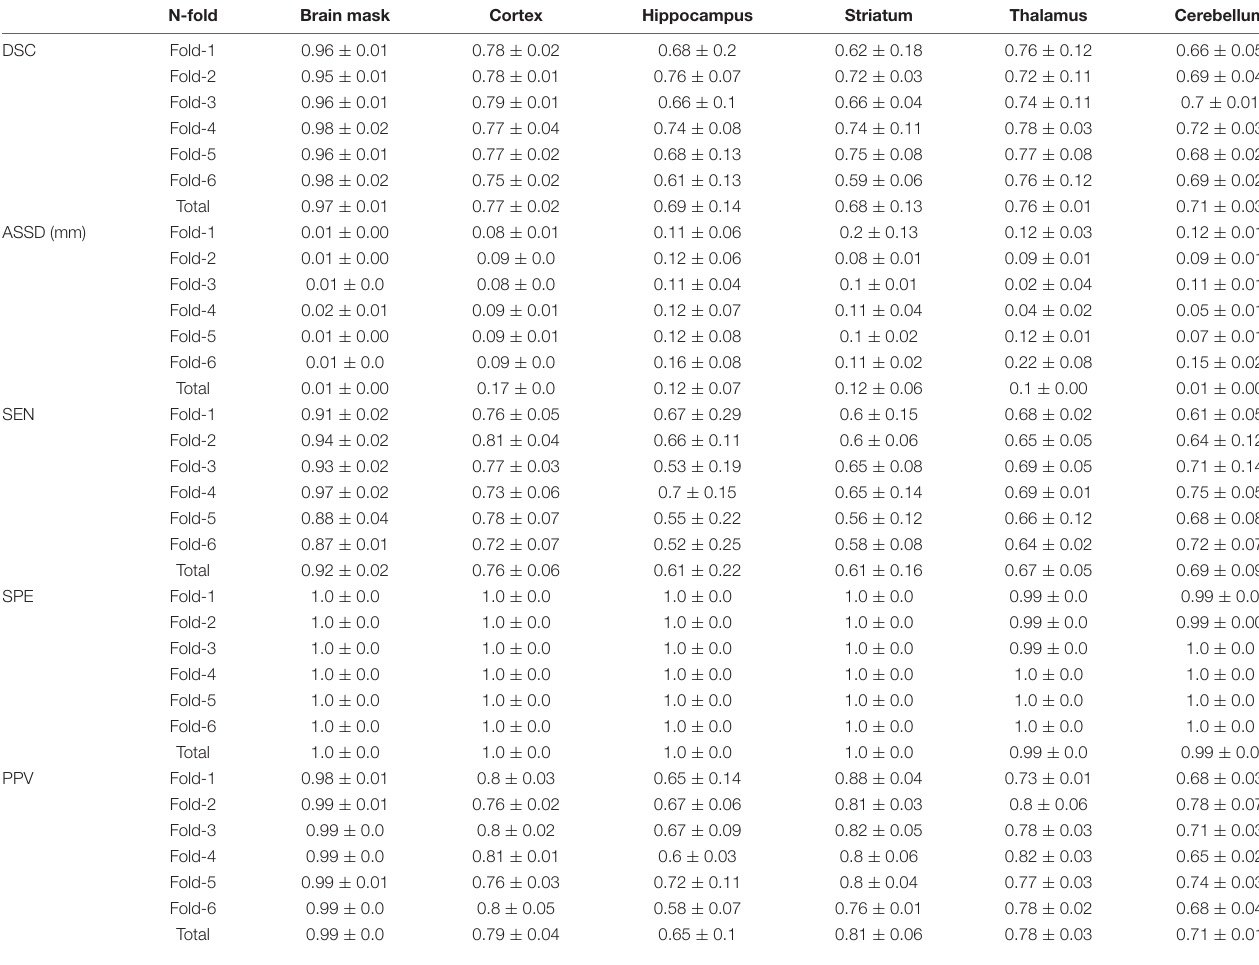
TABLE 1 | Our unified deep neural network assessment through the mean and standard deviation of Dice similarity coefficient (DSC), average symmetric surface distance (ASSD) (mm), sensitivity (SEN), and positive predictive value (PPV) between DL labels and DL-generated brain masks and inversely normalized target VOIs (cortex, hippocampus, striatum, thalamus, and cerebellum) in six-fold crossvalidation.